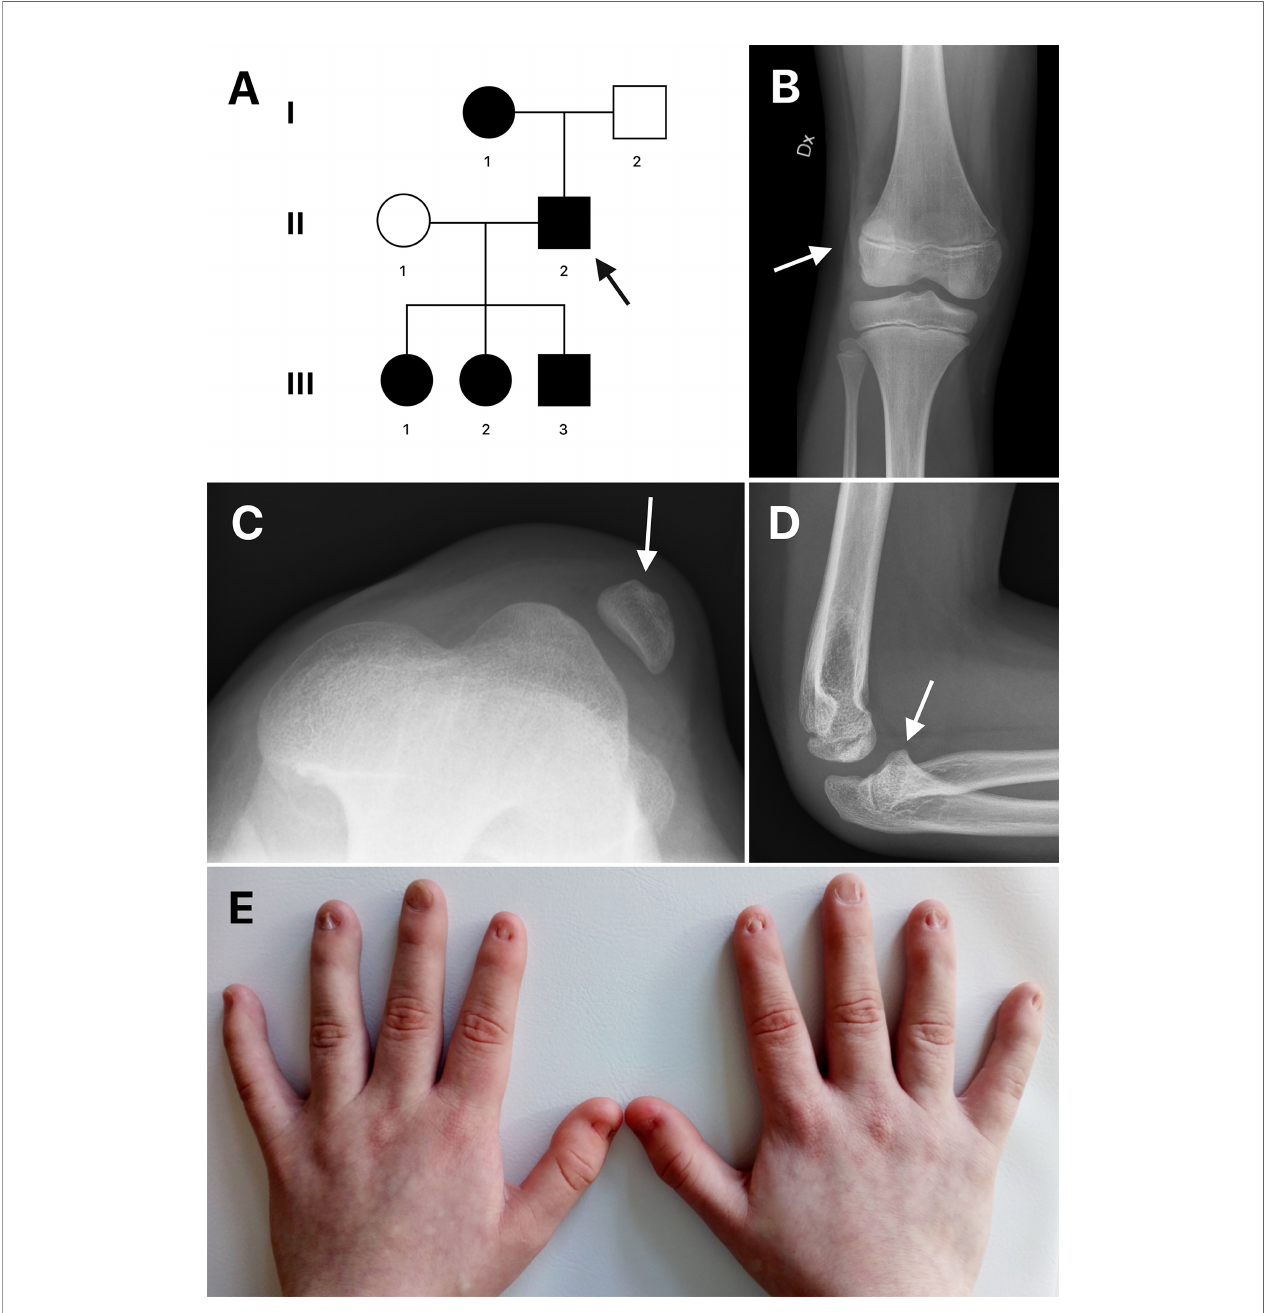
FIGURE 1 | (A) Pedigree of the family. Circles represent females and squares represent males. An arrow indicates the proband. Filled shapes represent affected individuals. (B, C) Radiographs of the right and left knee of patient III:1 showing laterally dislocated hypoplastic patella (arrows). (D) Radiograph of the left elbow of patient III:1 shows posteriorly dislocated radial head (arrow). (E) Dysplastic nails of patient